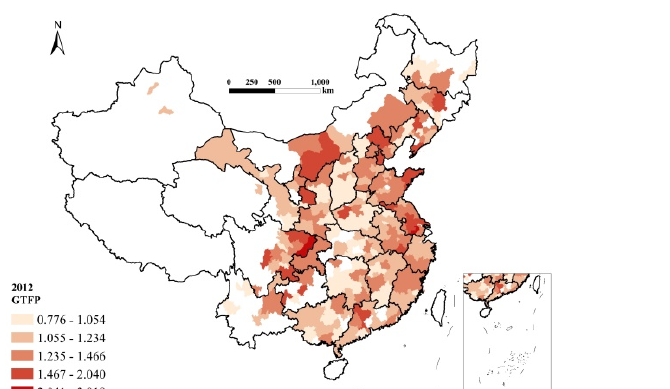
Table 3. Results of fixed effects and random effects models .